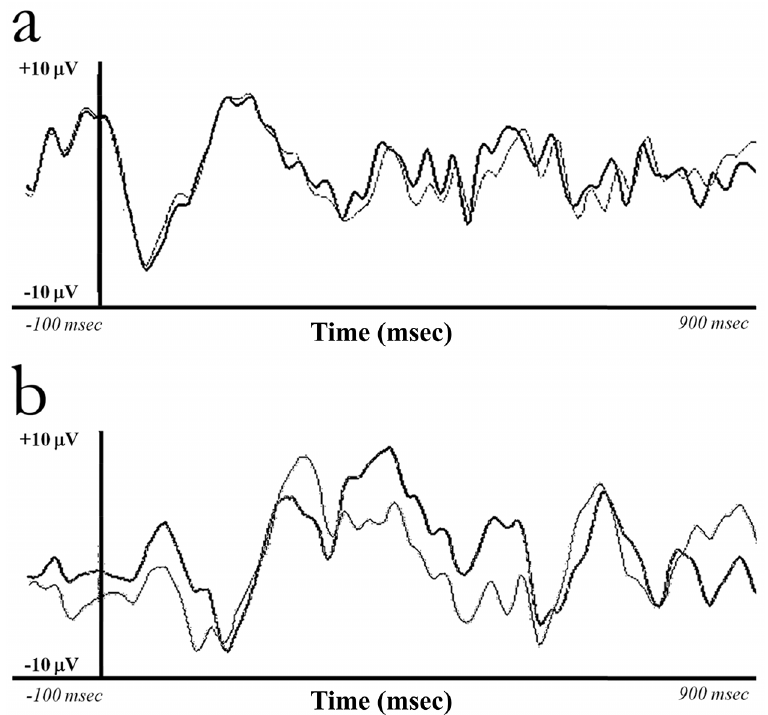
Fig 3. Grand average of Event Related Potentials in children with blindness (thick line) and their seeing counterparts (thin lines) following presentation of non-target stimuli on the line orientation (panel a) and letter recognition (panel b) tasks. The time frames for analysis of the P100 component were determined by searching for the maximal amplitude in the respective time window at the Pz electrode between 80 – 220